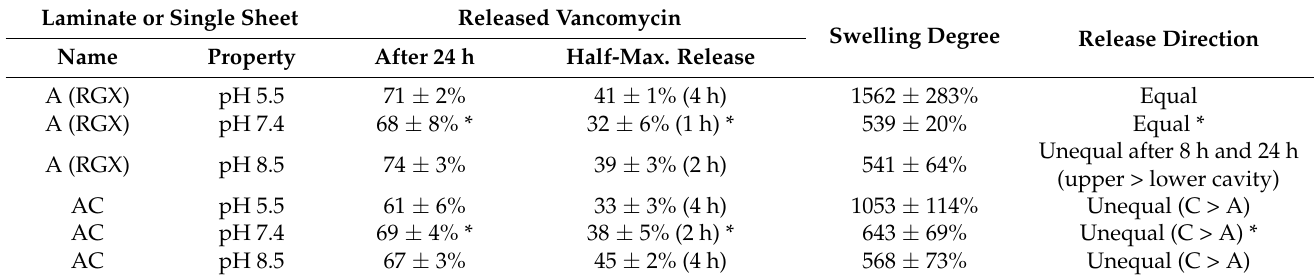
Table 1. Overview of the results. The data indicated by the asterisk refers to a previous publication by Kilb et al. and was added to the table for comparison